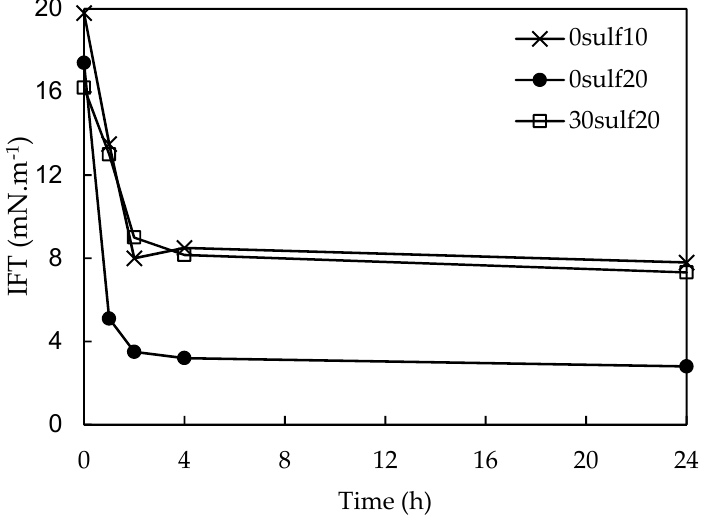
Figure 12. IFT behavior over time for systems containing 0.1 ( m / v ) % suspensions and mineral oil. Measurements were carried out using the Du Nouy method (temperature: 25 ± 0.5 °C).